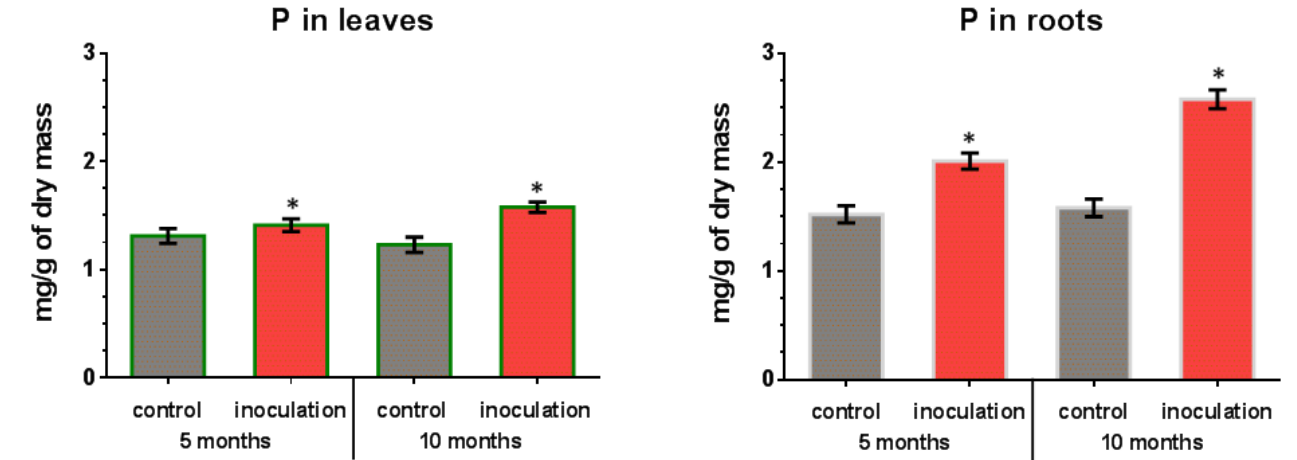
Figure 6. Phosphorus (P) content in V. macrocarpon leaves and roots after 5 and 10 months of co-cultivation with P. fortinii DSE2 isolate. *—phosphorus content in inoculation variant is significantly higher than in control variant, p < 0.05.